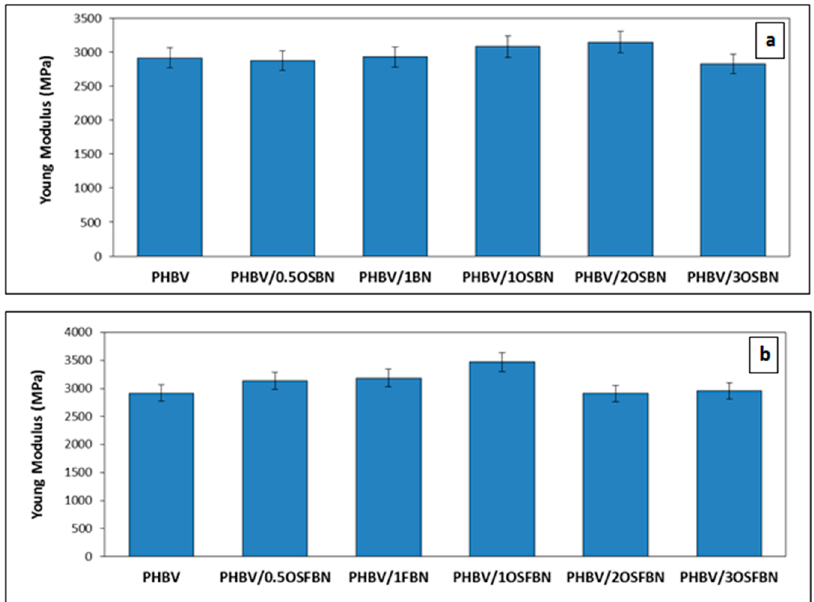
Figure 9. Young’s modulus values of ( a ) PHBV/BN and ( b ) PHBV/FBN nanocomposites.